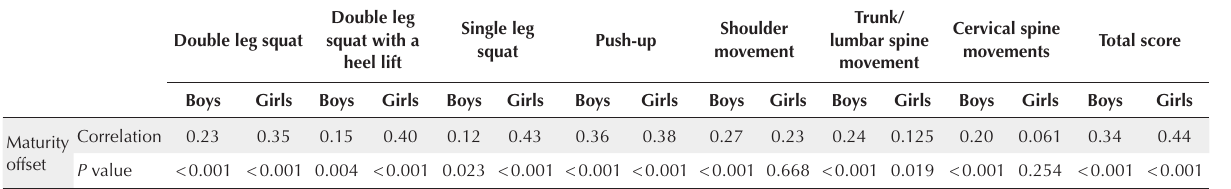
Table 4. Correlation of Maturity Offset and Fusionetics Scores